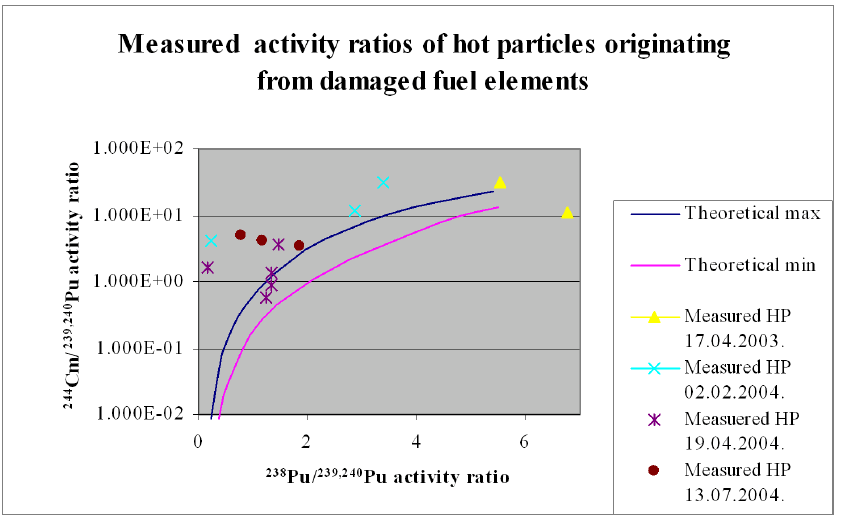
Fig. 8 Measured activity ratios of hot particles originating from damaged fuel